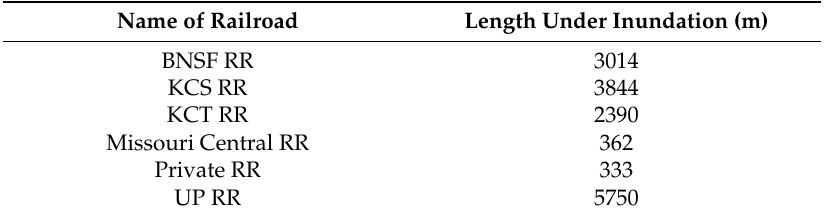
Table 8. List of railroads vulnerable to the flood of May 2017 in Kansas City,